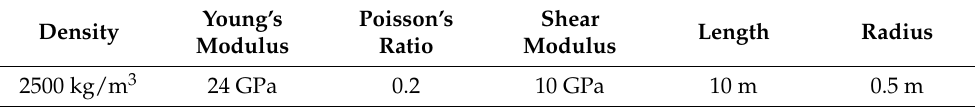
Table 2. Default pile parameters utilized for model verification and parametric